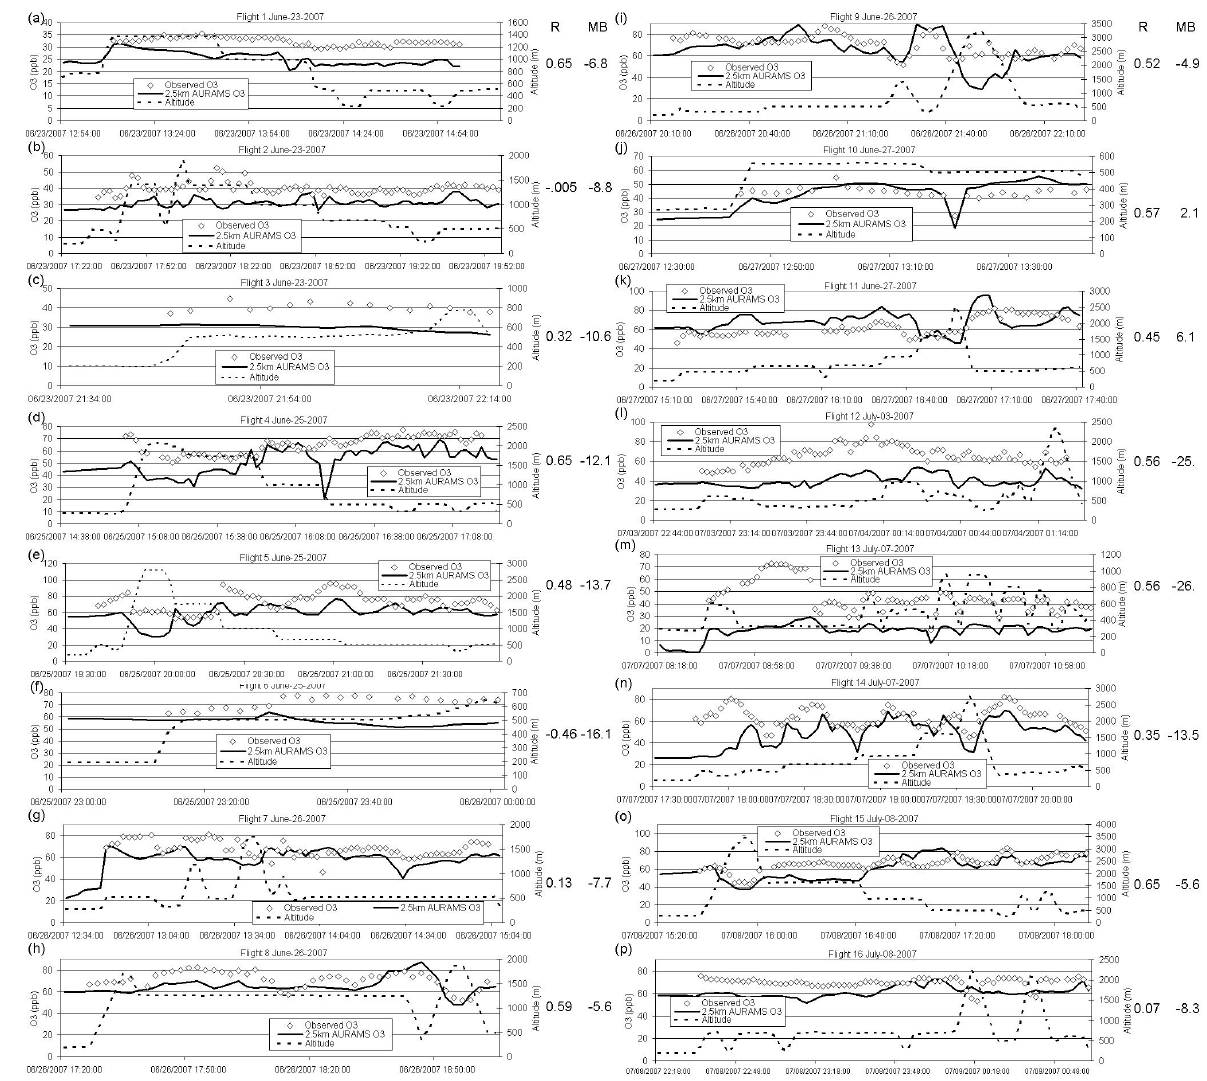
Fig. 4. (a–h) Observed and simulated O 3 (ppbv), first 8 flights. (i–p) Observed and simulated O 3 (ppbv), remaining 8